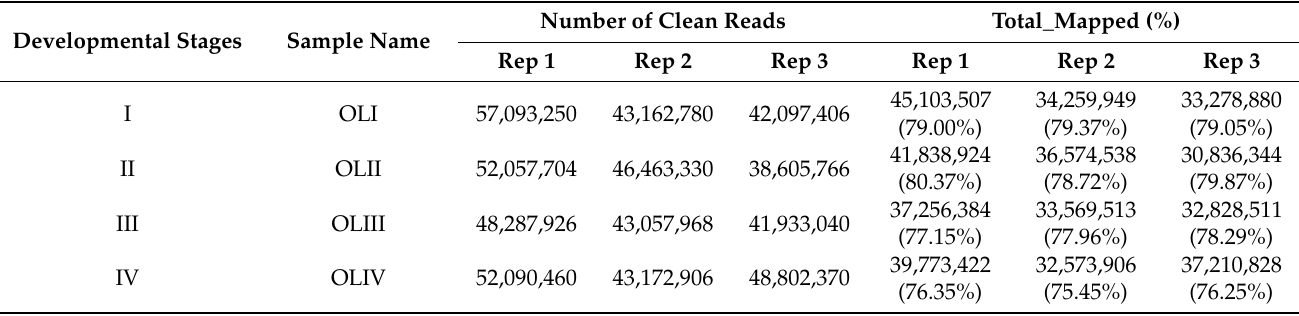
Table 1. Overview of the samples for